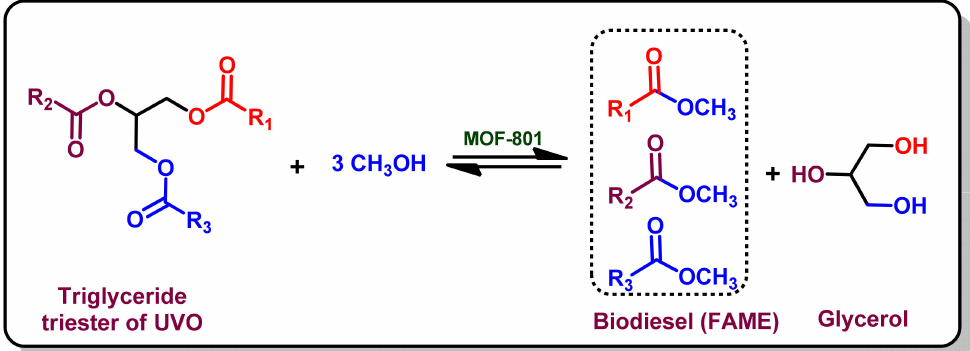
Figure 6. Graphical illustration of the transesterification of triglycerides with methanol.